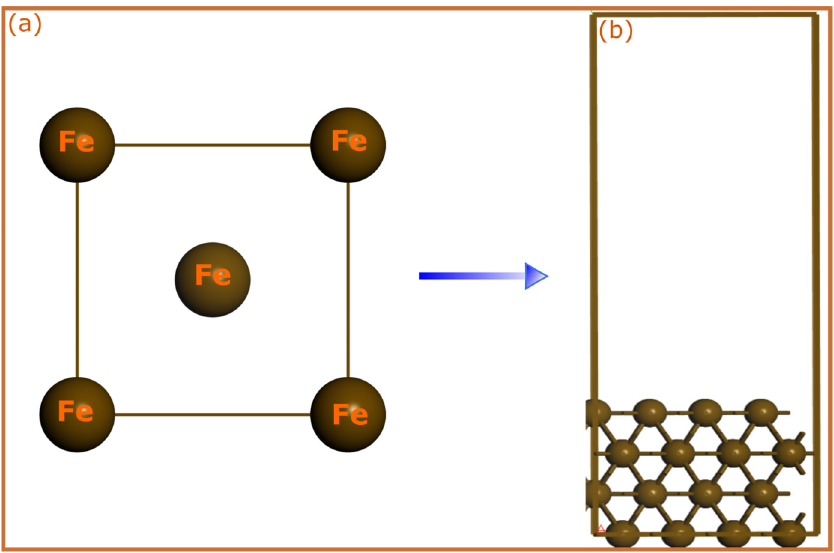
Figure 8. ( a ) iron crystal structure and ( b ) DFTB simulation box used for simulating pyridines ad- sorption on the iron surface. adsorption on the iron